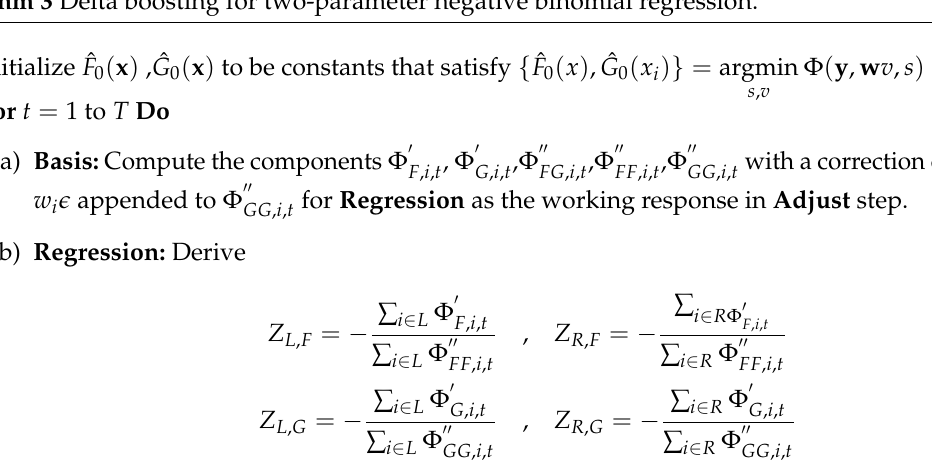
Algorithm 3 Delta boosting for two-parameter negative binomial